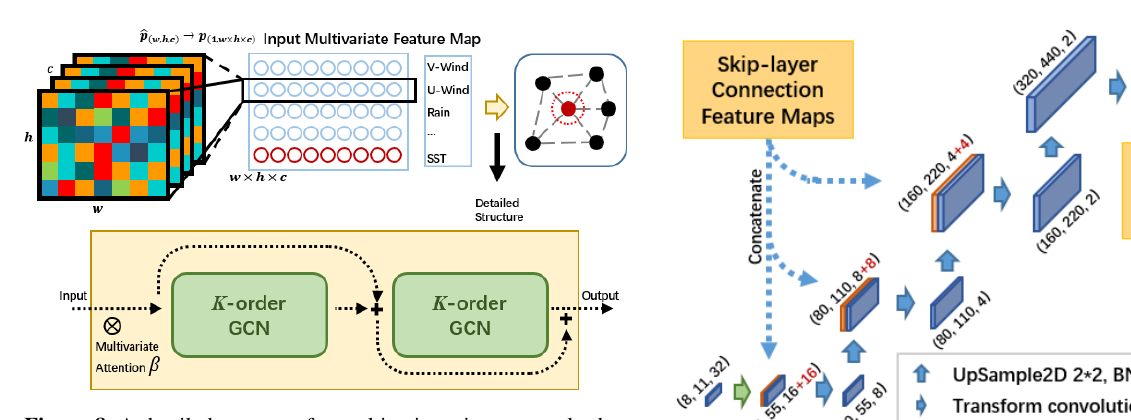
Figure 8. A detailed structure for multivariate air–sea coupler be- tween encoder and decoder: pre-processes for input (upper row), and dual-layer structure for residual learning (lower row). There is also a multivariate attention weight in the coupler.